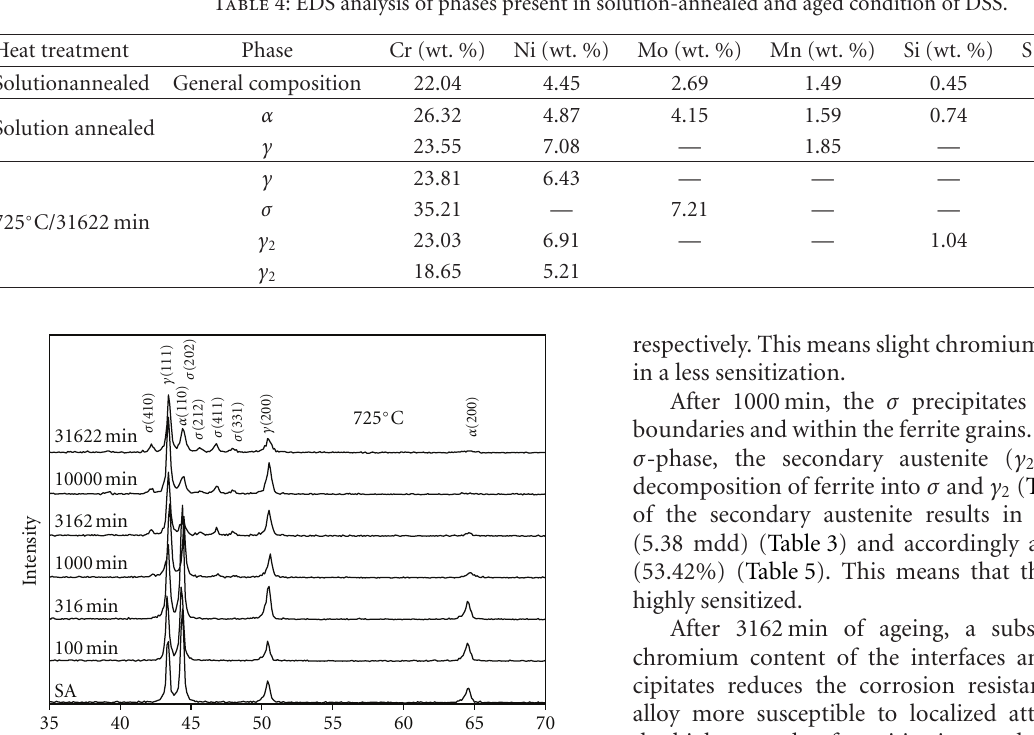
Table 4: EDS analysis of phases present in solution-annealed and aged condition of DSS.